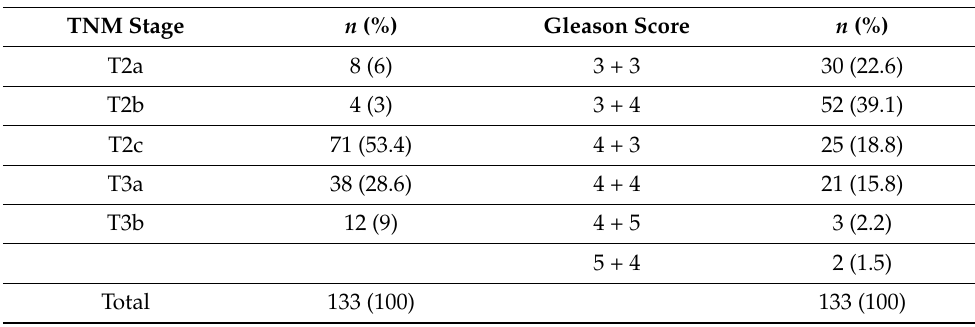
Table 2. Tumor classification after